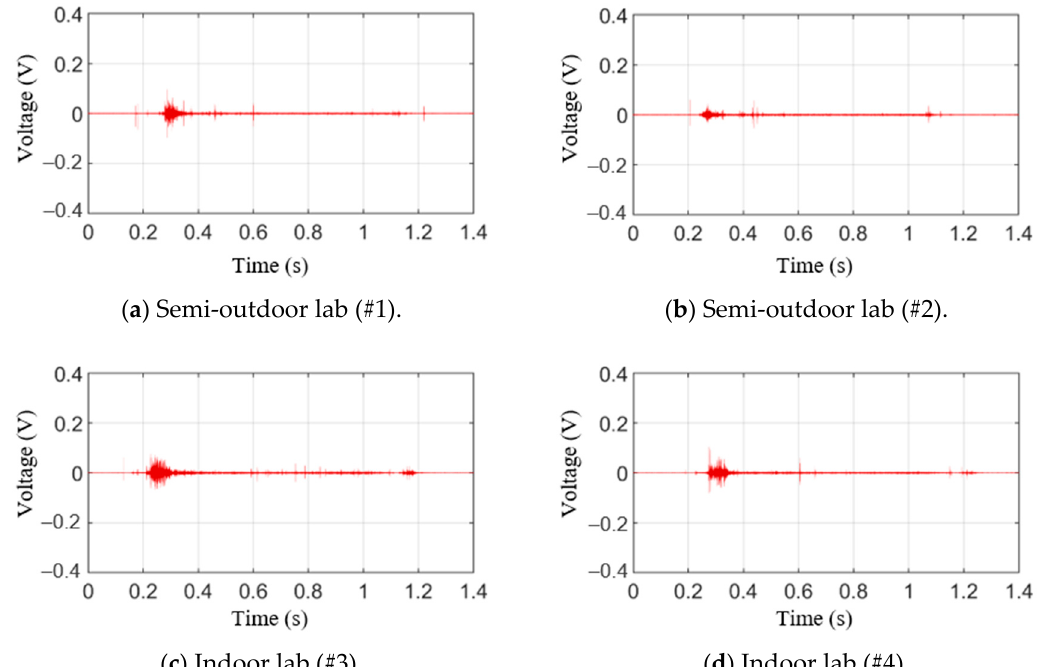
Figure 14. AE filtered signal with press process.